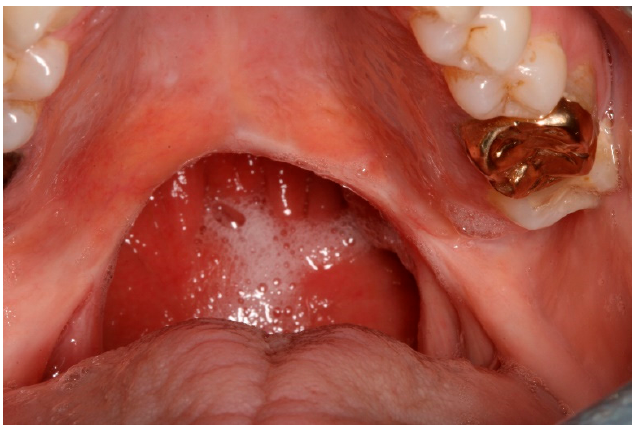
Figure 1. Intra-oral view showing the healed tissues following wide surgical excision of the soft